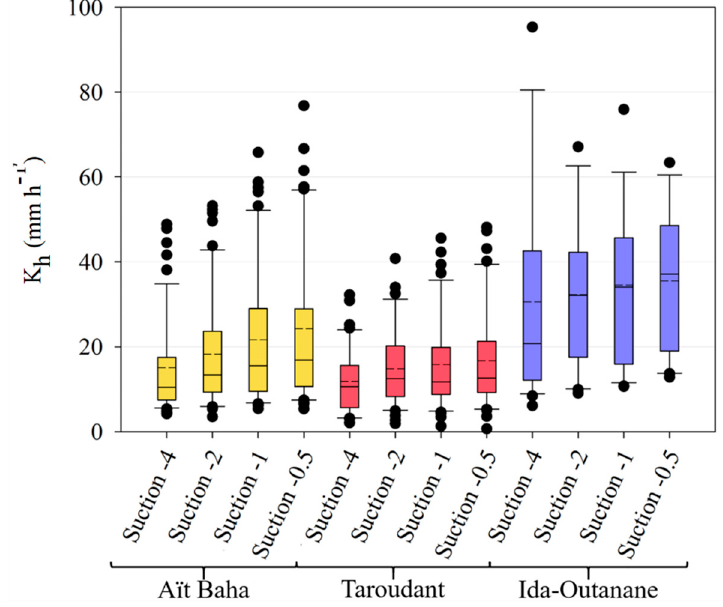
Figure 10. Unsaturated hydraulic conductivity (K h ) for different suctions ( − 4 to − 0.5) for the three study areas (short dash: mean line, solid line: median, dots: outliers).